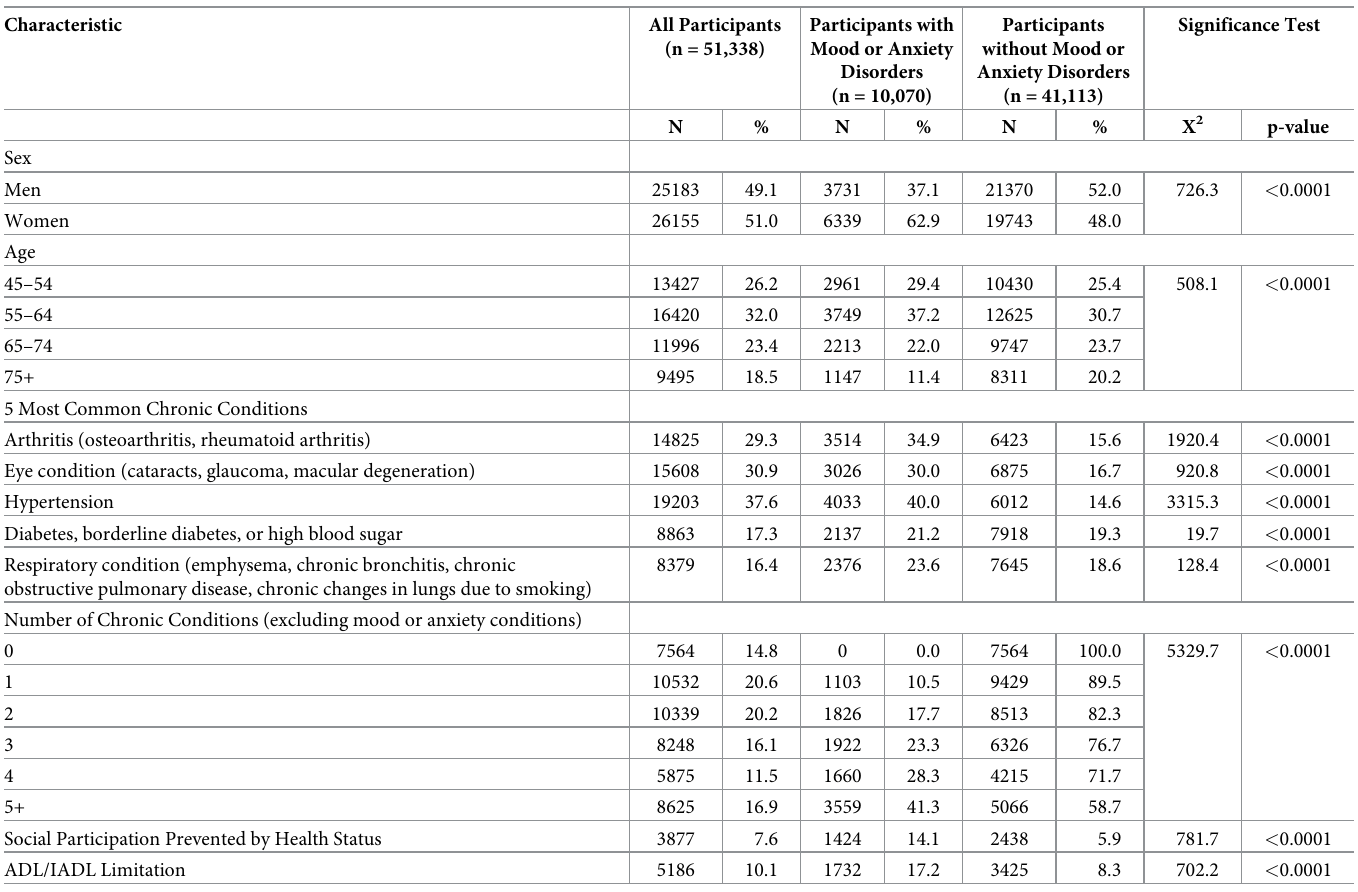
Table 2. Characteristics of the 51,338 participants of the Canadian Longitudinal Study on Aging.